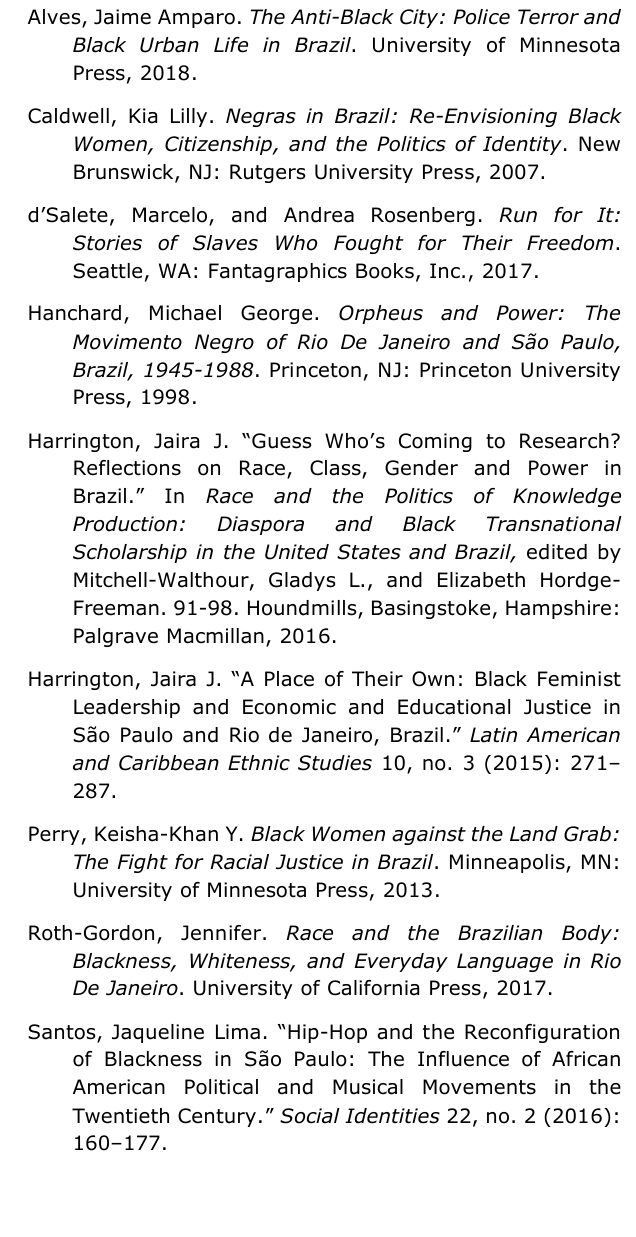
A Seat at the Table: Intersectionality and Black Women in